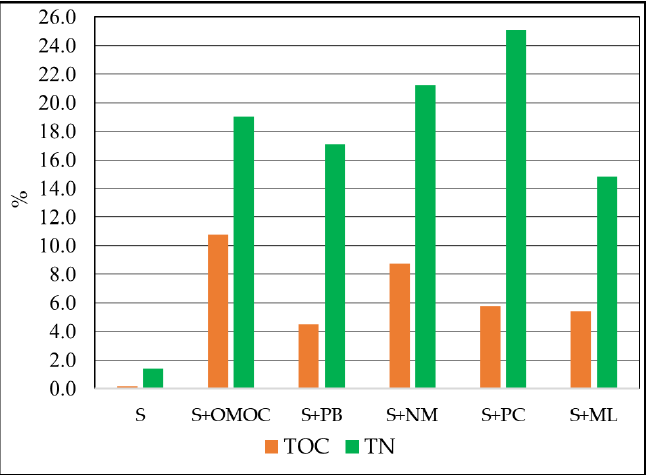
Figure 1. Percentage change in the TOC and TN content between the initial and final incubation stages.